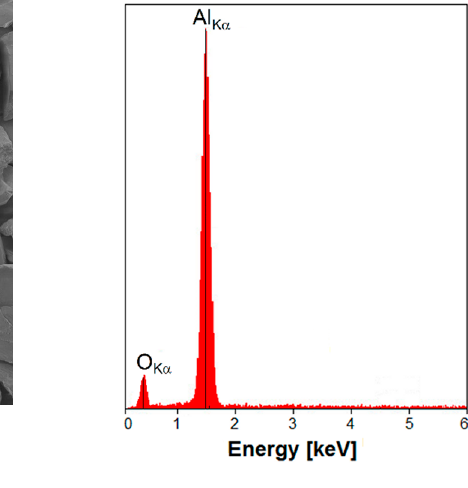
Figure 2. ( a ) SEM image of the Ti G4 machine surface; ( b ) EDS spectrum in the micro-region of the machine surface.